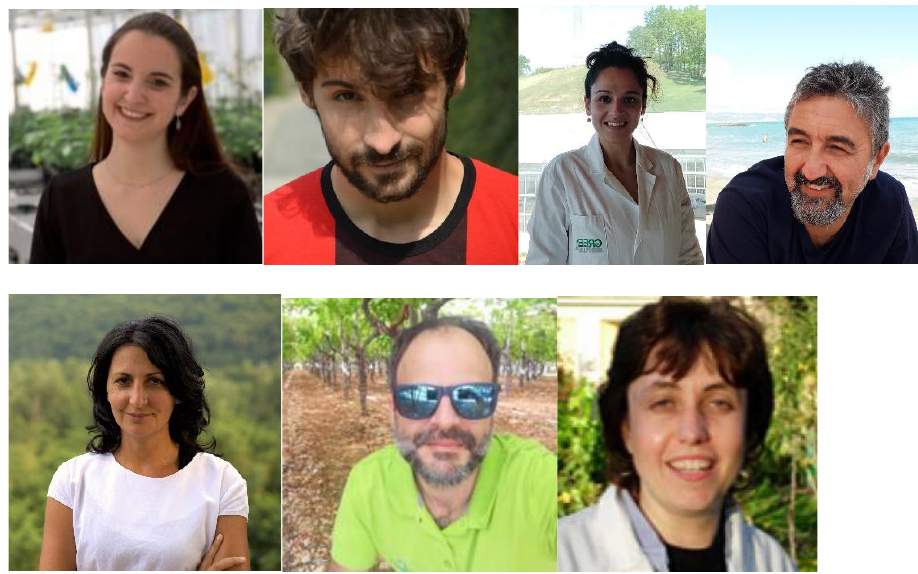
Figure 4. Cristina Campobenedetto, Giuseppe Mannino, Chiara Agliassa, Alberto Acquadro, Vale- ria Contartese, Christian Garabello and Cinzia Margherita Bertea (From left to right, top to